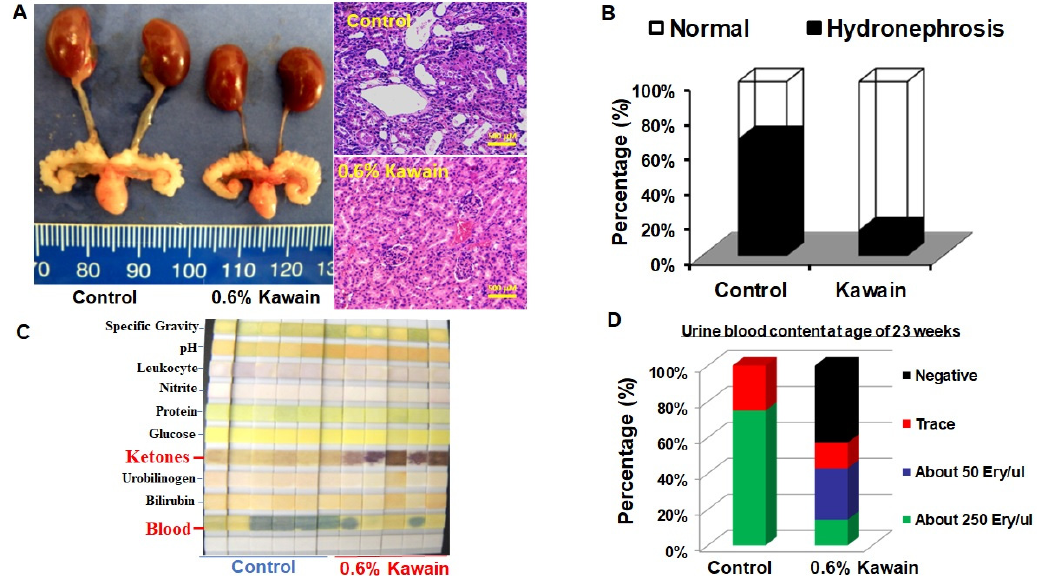
Figure 3. Kawain diet reduces the occurrences of hydronephrosis and hematuria. ( A ) macro- graphic and micrographic examination of enlarged kidneys and ureters. ( B ) Percentages of mice with hydronephrosis were shown in mice fed with the indicated diet. ( C ) Photographs of dipsticks after dipping with urine from male UPII-mutant Ha-ras mice fed with indicated diet at the age of 23 weeks. ( D ) Percentages of mice with hematuria shown in control and kawain diet fed mice.